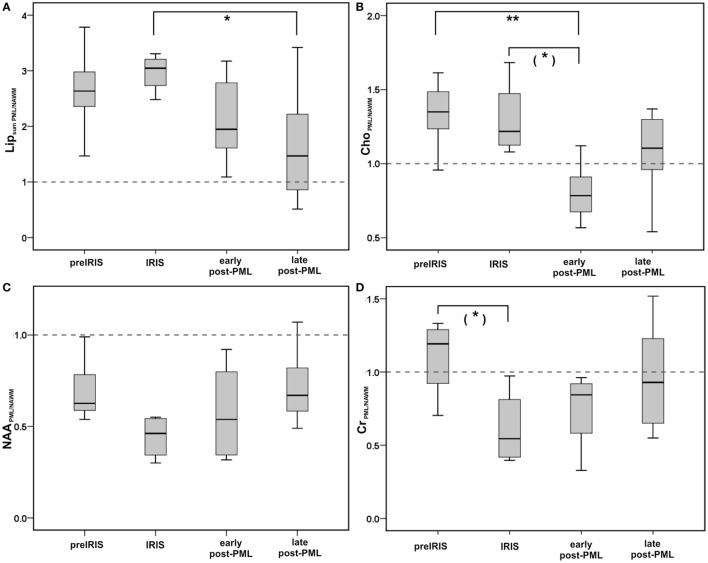
Group comparisons between different PML phases shown as boxplots for single metabolite ratios comparing PML lesions with contralateral NAWM for NAAPML/NAWM, and Lipsum PML/NAWM
(A): upper row left panel, ChoPML/NAWM
(B): upper row right panel, NAAPML/NAWM
(C): lower row left panel, CrPML/NAWM
(D): lower row right panel. Boxes: interquartile range, line: median, error bars: minimum-maximum; Significant group differences (pairwise testing after significant Kruskall Wallis tests; corrected for multiple comparisons by Dunnett–Bonferroni tests) are marked by ** if p < 0.010, * if p < 0.050, (*) for trends: 0.050 ≤ p < 0.100.